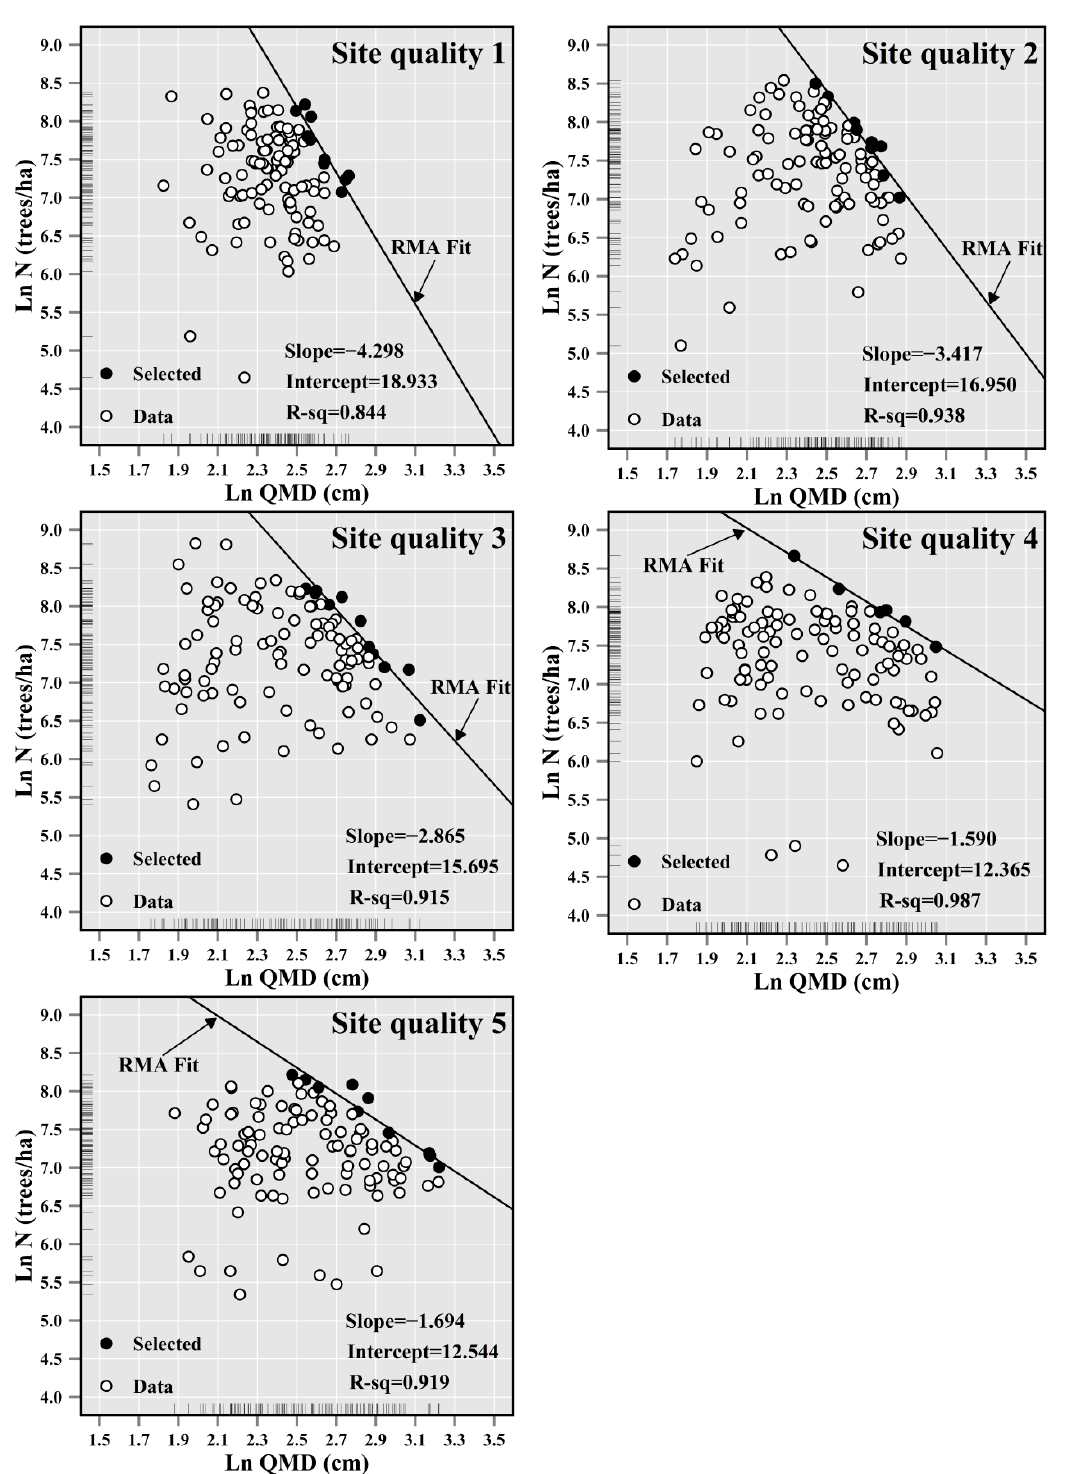
Figure 2. The maximum size-density line in the 5 different site quality categories (Site quality 1 < Site quality 2 < Site quality 3 < Site quality 4 < Site quality 5) classified based on site index.